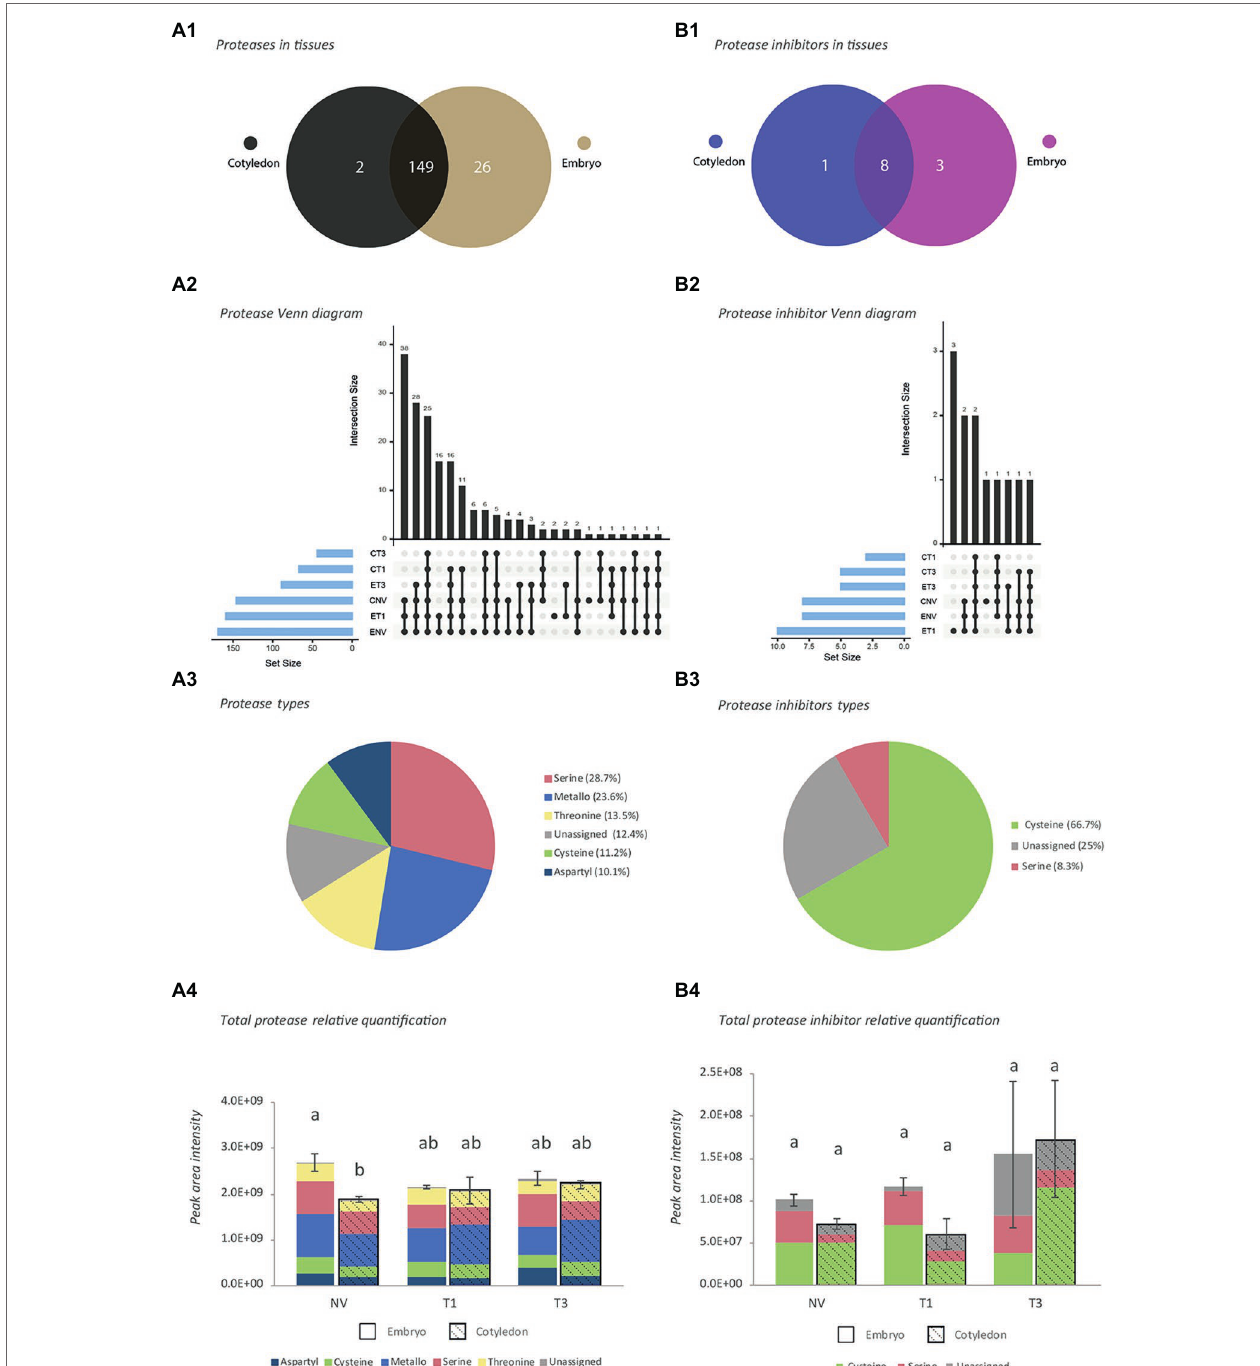
FIGURE 1 | Characterization of proteases and protease inhibitors identified by shotgun analysis. (A) Proteases. (B) Protease inhibitors. 1: Venn diagram at tissue level, 2: Venn diagram at stage level, 3: Activity-type classification, 4: Total protein abundance based on combined peak areas. NV: Nongerminated acorns after 4 weeks of germination. T1: mature acorns prior to germination. T3: germinated acorns when root tip size reached 6.5 mm. The same letter indicates that there is no statistical difference between tissues or